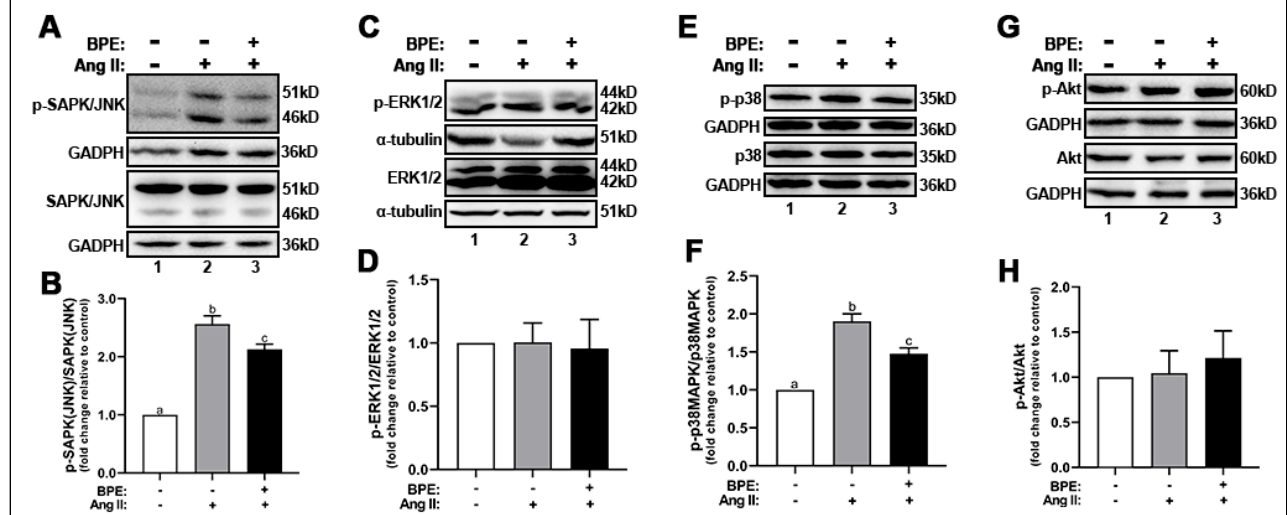
Figure 2. Blueberry polyphenol extract (BPE) attenuates SAPK/JNK and p38 phosphorylation in angiotensin (Ang) II-treated human aortic endothelial cells (HAECs). HAECs were treated with 200 µg/mL of BPE for 1 h then treated with 200 nM of Ang II for 12 h. Protein expression of phosphorylated and total SAPK/JNK ( A , B ), ERK1/2 ( C , D ), p38 ( E , F ), and Akt ( G , H ) were determined by Western blot. Quantification was performed using Image Lab (Bio-Rad Laboratories, Inc., Hercules, CA, USA). Data are expressed as mean ± SD from three (SAPK/JNK), four (Akt) and five (ERK1/2 and p38) independent experiments. Values that do not share the same letter are significantly different from each other ( p ≤ 0.05).